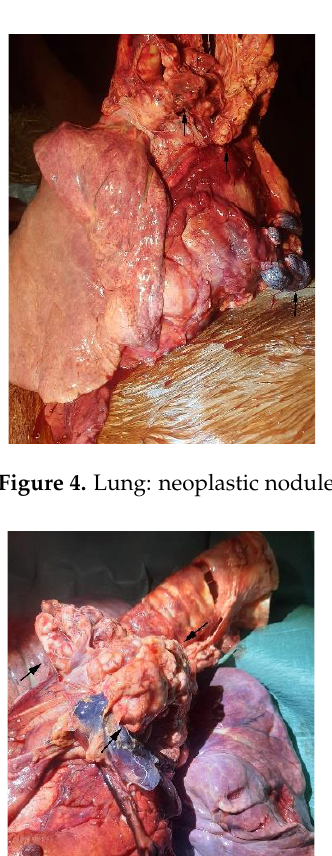
Figure 3. Lung: neoplastic nodules (arrows) and adhesions between the pleura and the chest wall.